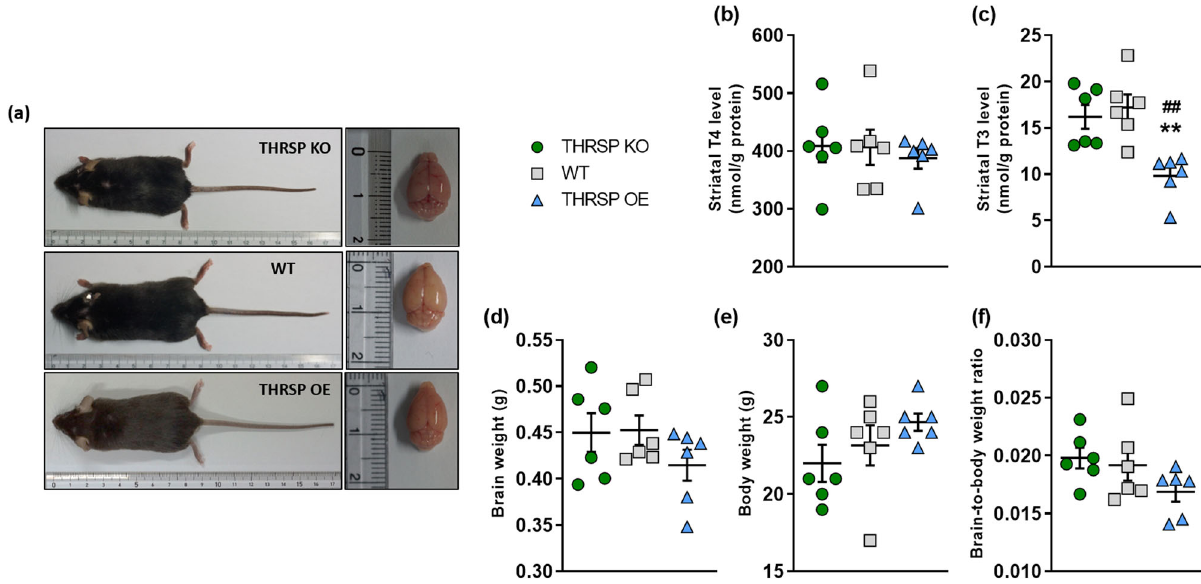
Fig. 5 THRSP OE mice have reduced striatal T3 levels with moderately low brain-to-body weight ratio. a A snapshot of mice and their brains. b T4 and c T3 were evaluated ( n = 6 mice/group; b one-way ANOVA, F (2,15) = 0.198, P = 0.822; c one-way ANOVA, F (2,15) = 10.4, P = 0.001). Also, the d brain and e body weights, and the corresponding f brain-to-body weight ratio in mice were assessed ( n = 6 mice/group; d one-way ANOVA, F (2,15) = 1.38, P = 0.282; e one-way ANOVA, F = 1.54, P = 0.246; f one-way ANOVA, F = 2.17, P = 0.148). THRSP overexpression reduced the striatal T3 levels (2,15) (2,15) in mice accompanied by moderately low brain-to-body weight ratio. Values are presented as the mean ± S.E.M. ** P < 0.01 (relative to WT) and ## P < 0.01 (relative to THRSP KO), by one-way ANOVA with Bonferroni ’ s multiple comparison THRSP OE mice, presenting low spontaneous alternations (Supplementary Fig. 7b) in the Y-maze test and low discrimina- tion index (Supplementary Fig. 7d) in the NORT. According to